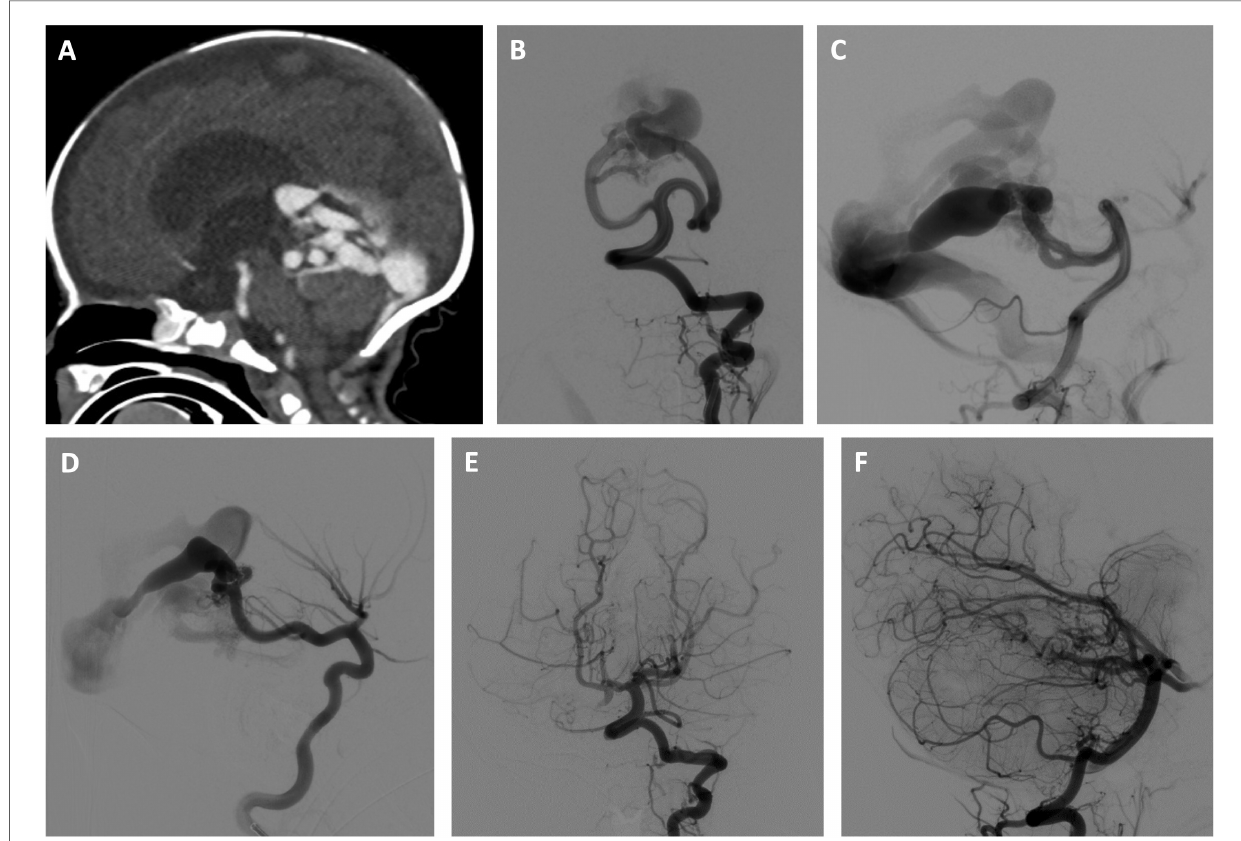
FIGURE 1 Three-stage embolization of congenital high- fl ow vermian arteriovenous malformation with acrylic and ethylene vinyl alcohol copolymer using adjunctive right ventricular overdrive pacing for fl ow control. Newborn male initially presenting with mild neonatal heart failure, which resolved. The patient subsequently experienced failure to thrive and was found to have progressive hydrocephalus. Brain imaging studies revealed a congenital high- fl ow vermian arteriovenous malformation (AVM) featuring multiple arteriovenous macro fi stulae. The patient was treated by two stage transarterial embolization using adjunctive RVOP for fl ow-control during the fi rst 4 weeks of life and made a dramatic clinical improvement. Use of the RVOP technique was selected for this case given the anticipated extremely rapid transit of embolysate through the high- fl ow shunt. A transvenous approach was not selected due to the anticipated challenge of navigating a microcatheter through the profoundly dilated venous anatomy. A transarterial balloon-assisted embolization was not selected due to multiple high- fl ow arterial inputs that could continue to propel the embolysate downstream despite balloon in fl ation. In the fi rst embolization session, the left superior cerebellar artery supply to the AVM was embolized with a mixture of 80% n-BCA and 20% Ethiodol, and the right posterior cerebral artery supply to the AVM was embolized with a mixture of 90% n-BCA and 10% Ethiodol. An Echelon 10 ® microcatheter (Medtronic, Santa Rosa, CA) was used in both instances. In the second embolization session, embolization of the left superior cerebellar artery contribution was completed using Onyx 34 ® (Medtronic, Santa Rosa, CA), and embolization of of the right superior cerebellar artery supply to the AVM was performed with a mixture of 90% n-BCA and 10% Ethiodol. In both instances, a 1.5 cm detachable tip Apollo ® microcatheter (Medtronic, Santa Rosa, CA) was used. A third stage transarterial Onyx 34 ® (Medtronic, Santa Rosa, CA) embolization was electively performed 6 months later without RVOP, resulting in complete initial angiographic occlusion of the